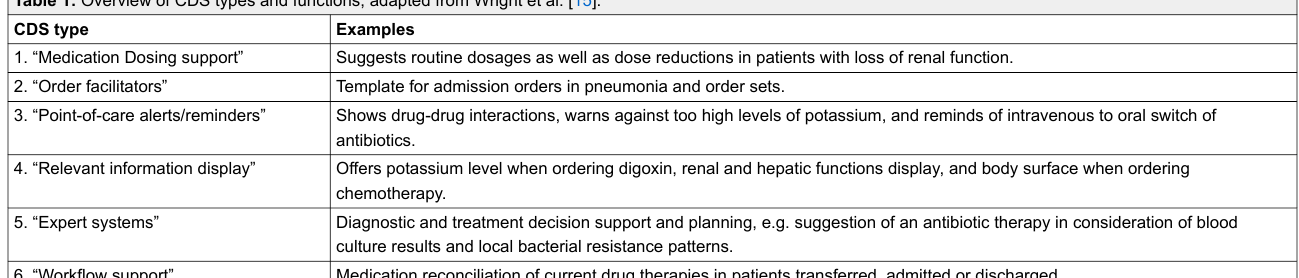
Table 1: Overview of CDS types and functions, adapted from Wright et al.